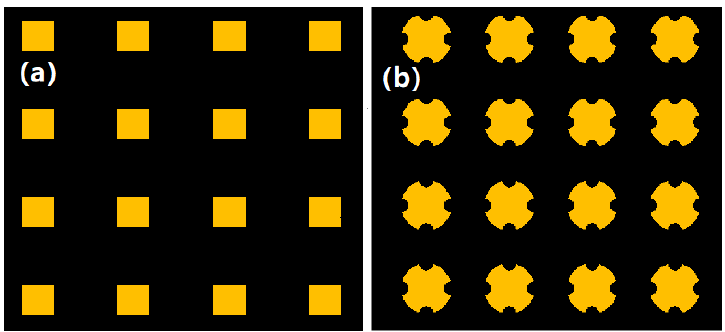
Figure 9. Lithography mask pattern. ( a ) Square pattern. ( b ) Circular pattern with four grooves.